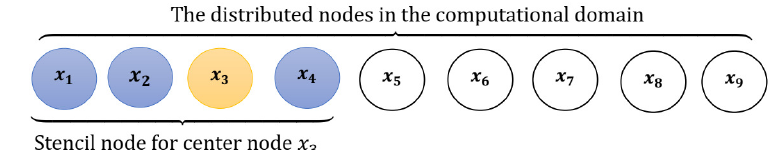
Figure 1. Illustration of one-dimensional case of stencil.